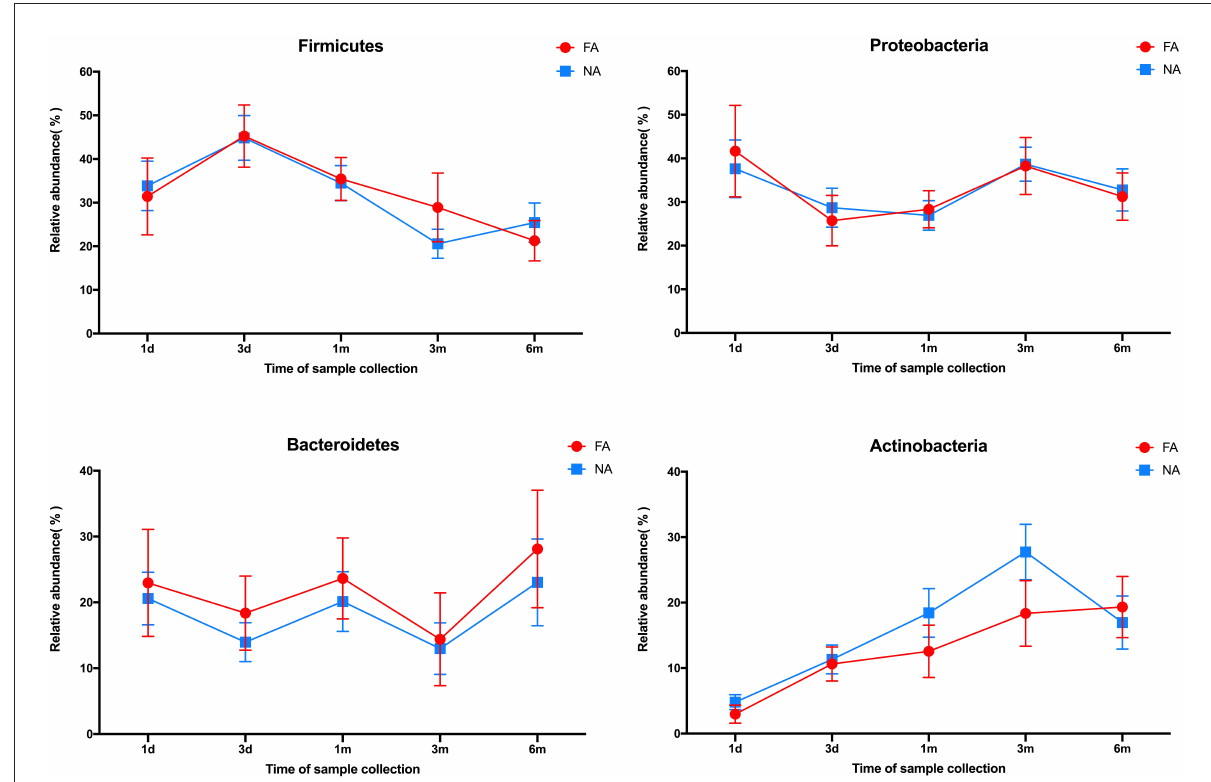
FIGURE6 Differences in the relative abundance of major phyla over time between the non-allergy (NA) and food allergy (FA) groups.